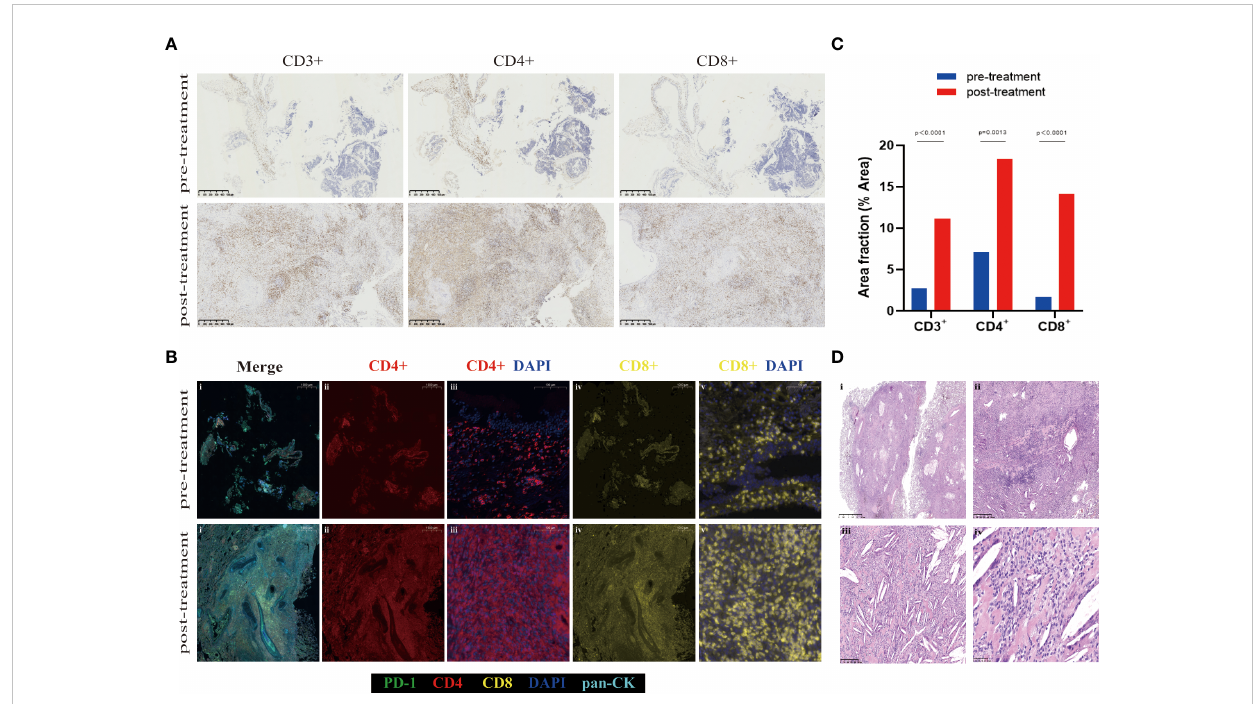
FIGURE 3 Representative images demonstrating changes in the tumor bed. (A) CD3+, CD4+, and CD8+ immunohistochemistry staining of the pre- and post- treatment specimen. (B) Multiplex immuno fl uorescent images of tumor tissue sections, which labels fi ve immune biomarkers within the tumor bed: PD-1 (green), CD4 (red), CD8 (yellow), DAPI (blue), pan-CK (light blue). Overall, the numbers of various immune cell phenotypes were higher in post- treatment specimens. (C) Area fraction of indicated immune cell populations in pre- and post-treatment. A signi fi cant increase in CD3+, CD4+, and CD8+ in the tumor bed is observed after neoadjuvant tislelizumab plus chemotherapy (multiple unpaired t -tests p <0.000, p = 0.0013, and p <0.000, respectively). (D) HE staining of post-treatment specimen shows in fl ammatory cells, a proliferation of fi brosis, cholesterol clefts, and granulomatous reaction after neoadjuvant tislelizumab plus chemotherapy. Scale bars: A = 500 µm. B: i, ii, and iv =1000 µm; iii and v = 100 µm. D: i = 2.5 mm; ii = 500 µm; iii = 250 µm; iv = 50